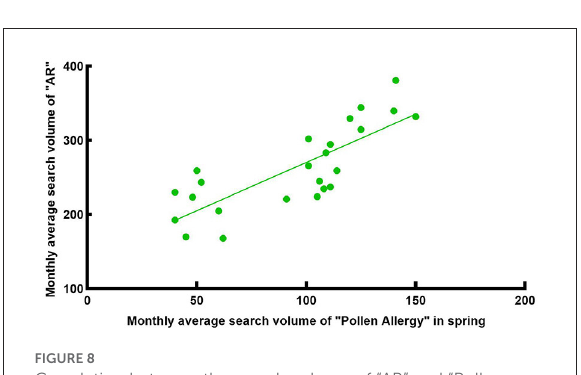
FIGURE8 Correlation between the search volume of “AR” and “Pollen Allergy” in spring from 2014 to 2021.